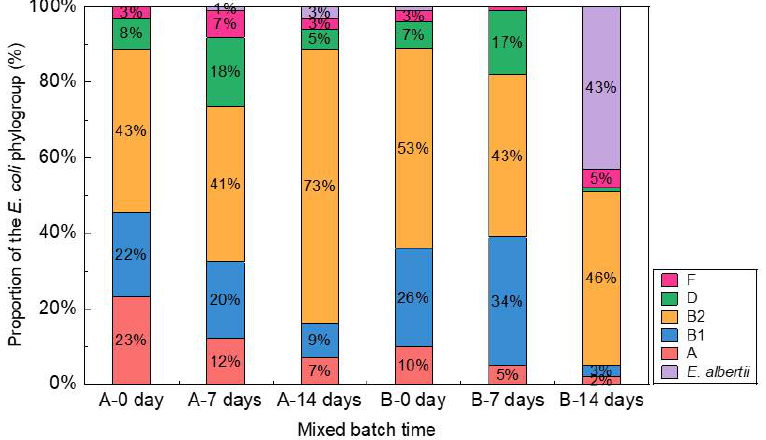
Figure 1. A bar chart of the cumulative percentage of E. coli isolates in wastewater samples collected from plants A and B in phylogenetic groups A, B1, B2, and D.